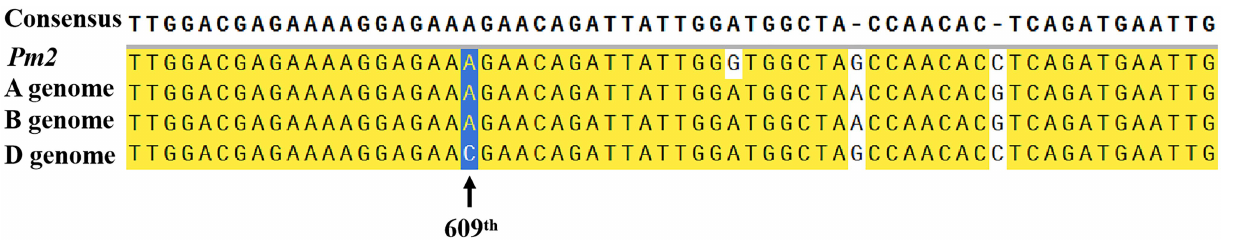
FIGURE 5 | Sequence alignment of the first exon of Pm2a and its homologous sequences in the A, B, and D genomes of common wheat Chinese Spring to identify distinctive SNPs for development of diagnostic